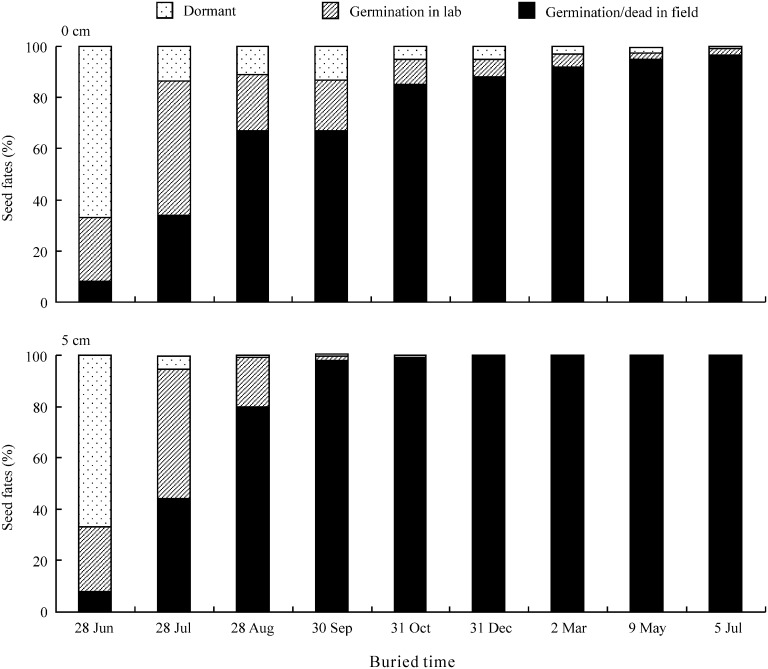
Fates of seeds in the field at 0 (surface) and 5 cm soil depths (n = 6).